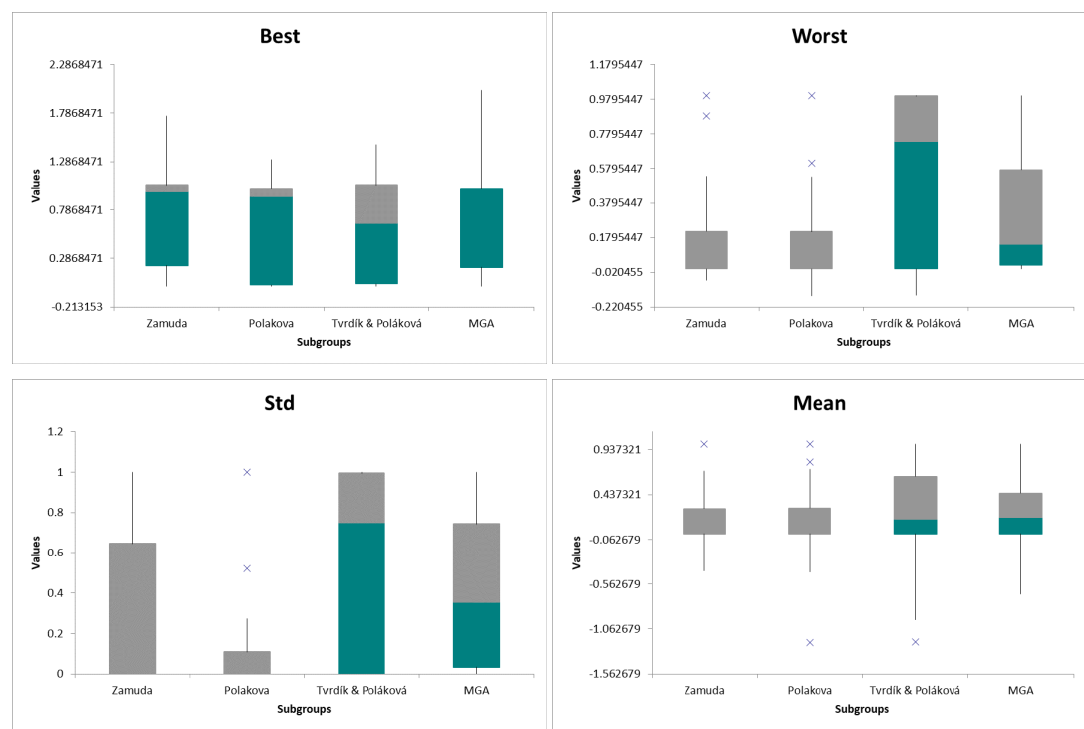
Figure 7. Box plots of the Analysis of Variance (ANOVA) for the 10-dimensional problems.